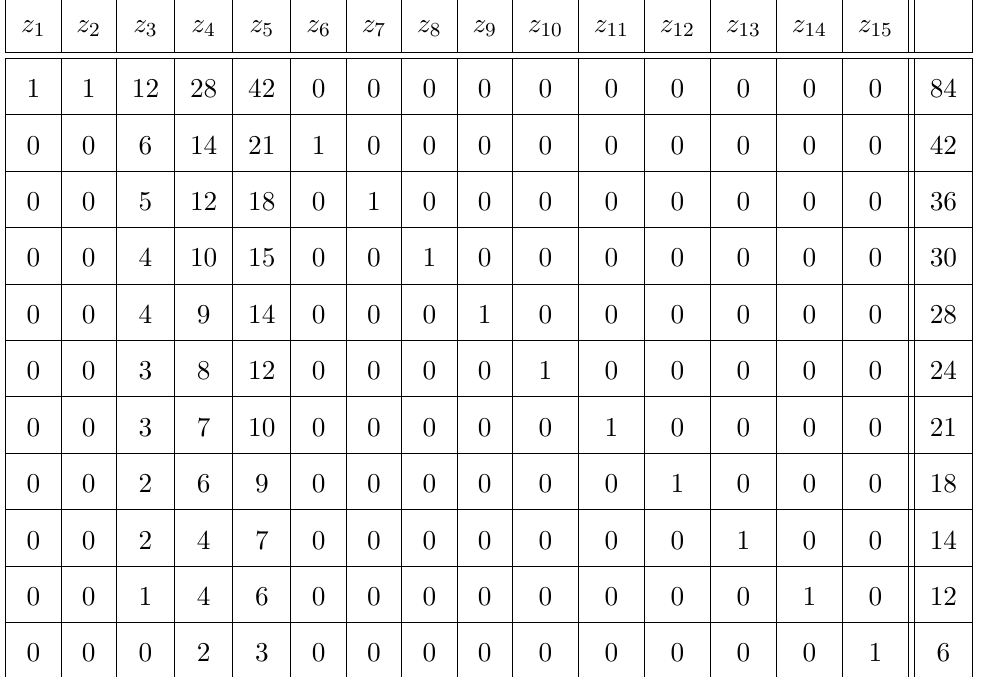
Table 6 . Weights for the model with h 1 , 1 = 11 and h 1 , 2 = 491